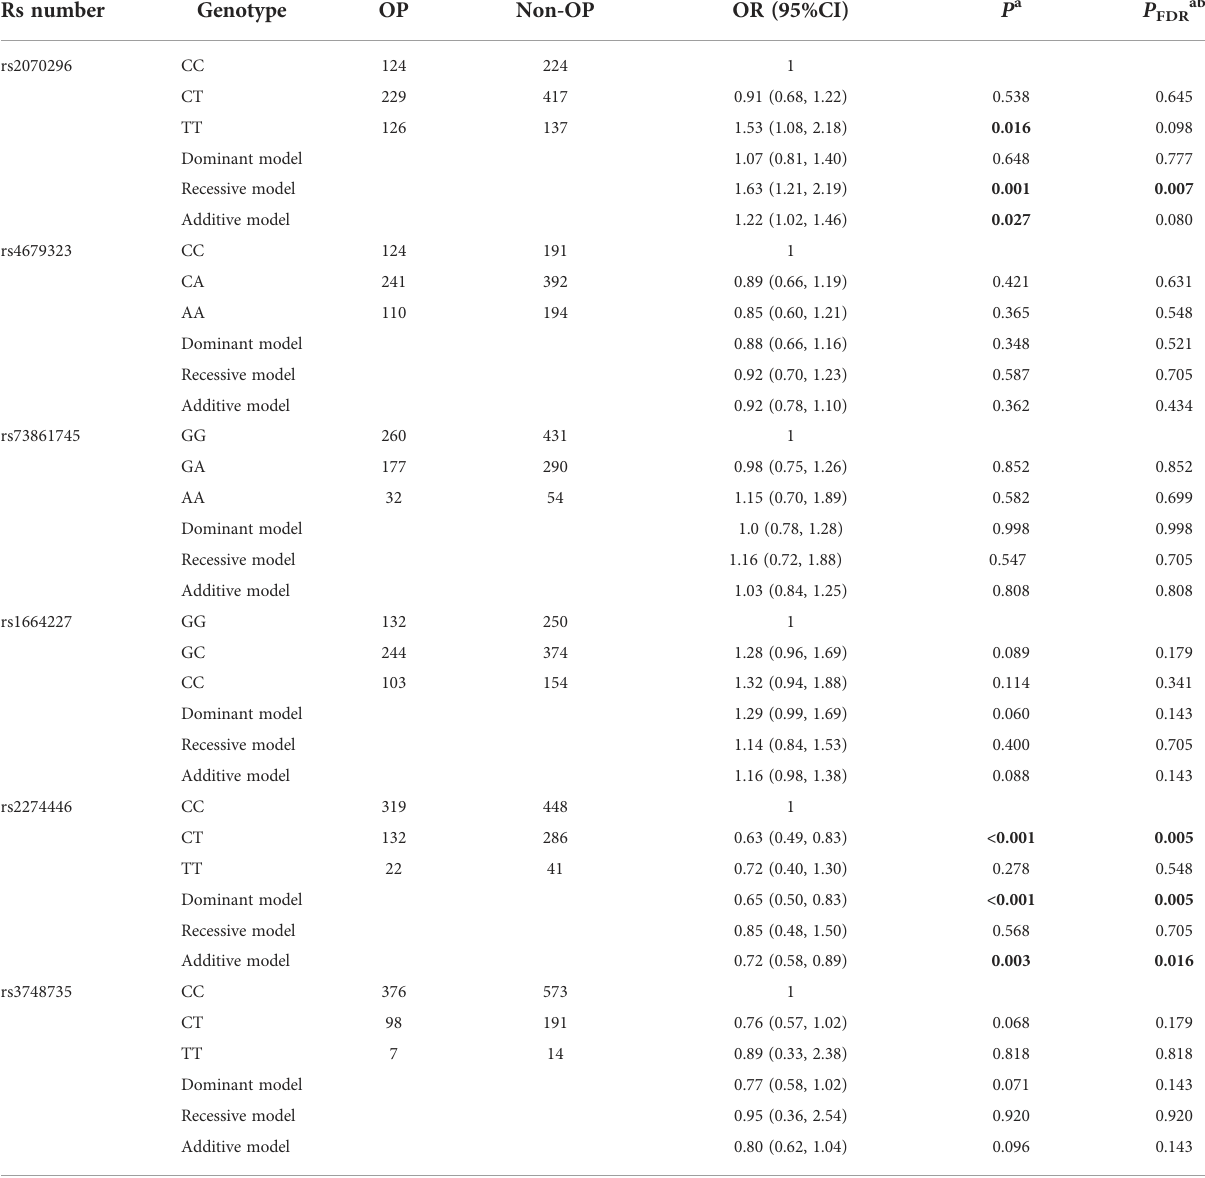
TABLE 4 Multivariate logistic regression results of associations between common genetic variants and OP risk in the combination dataset analysis. Rs number Genotype OP Non-OP OR (95%CI) P